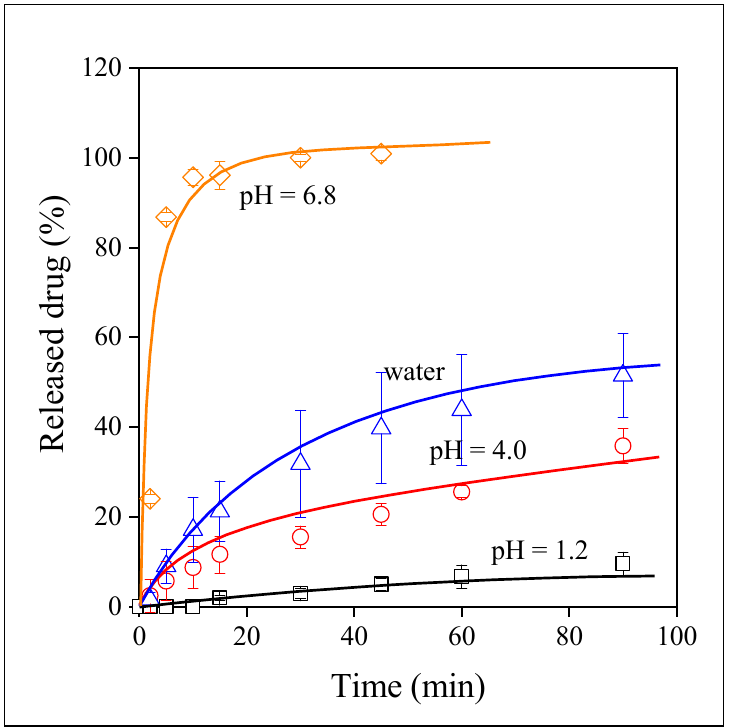
Figure 7. Time dependence of the dissolution of valsartan in various media. Symbols: ( ) pH 1.2, ( ) pH 4.0, ( ) pH 6.8, ( ) water.